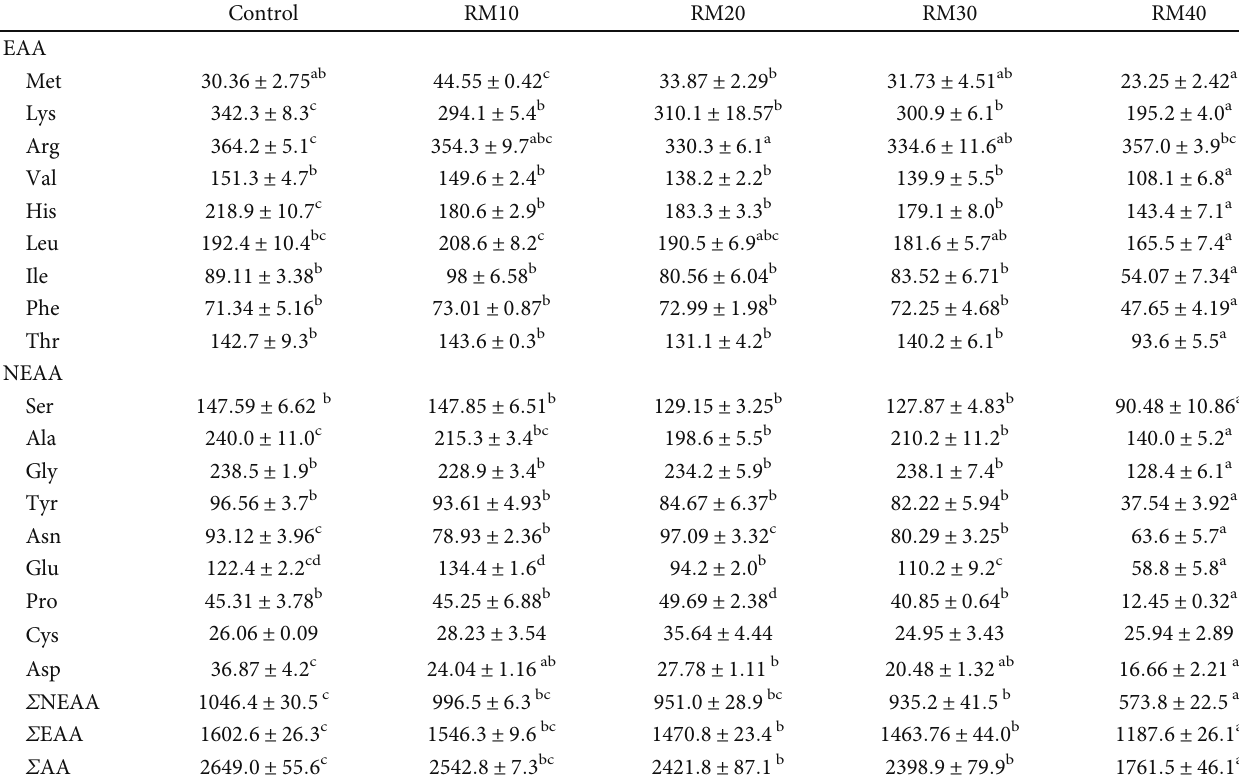
Values are means ± SEM ( n = 3 ), and the values with di ff erent superscript letters in the same row are signi fi cantly di ff erent ( P < 0 : 05 ). Table 5: Serum free amino acid concentration (nmol/ml) of juvenile yellow cat fi sh fed the experimental diets. Control RM10 RM20 RM30 RM40